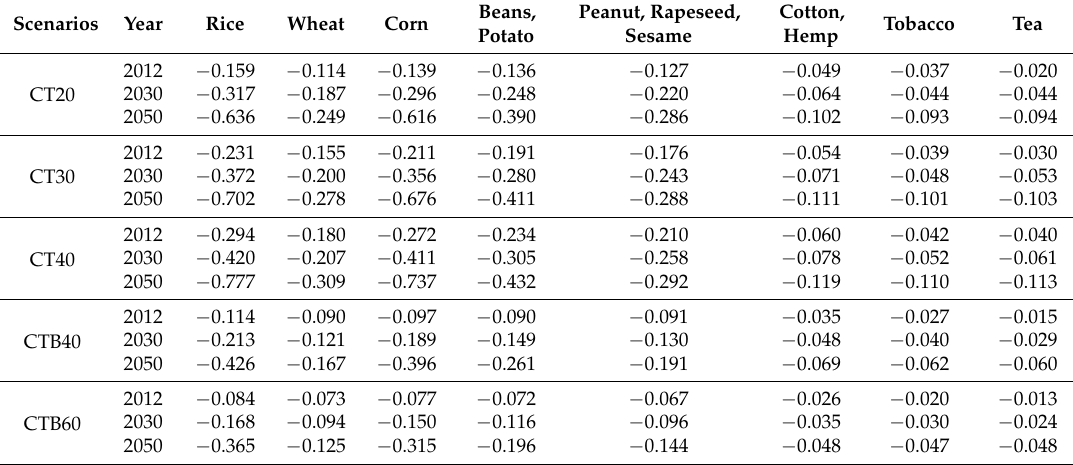
Table 8. The changes in outputs in agriculture-related sectors under different scenarios compared with the BAU scenario (%) (from rice to tea).